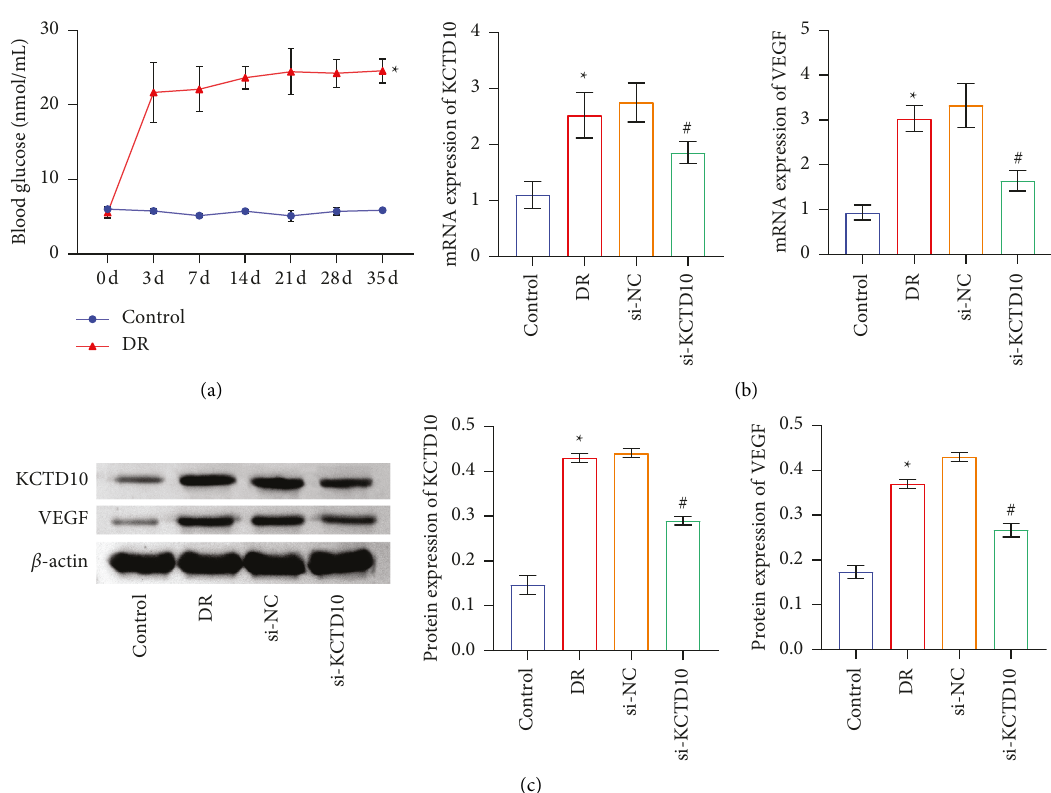
Figure 4: Expressions of KCTD10 and VEGF in DR animal model. (a) Changes in blood glucose levels with a duration of STZ intervention. (b), (c) KCTD10 and VEGF levels in the retinal tissues were identified by RT-qPCR and western blot detection. ∗ P < 0 . 05 versus the control group. # P < 0 . 05, versus the si-KCTD10 group.